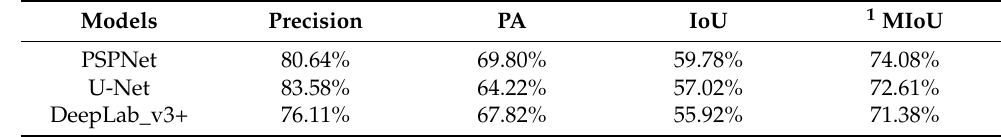
Table 3. The segmentation performance of main stems under different